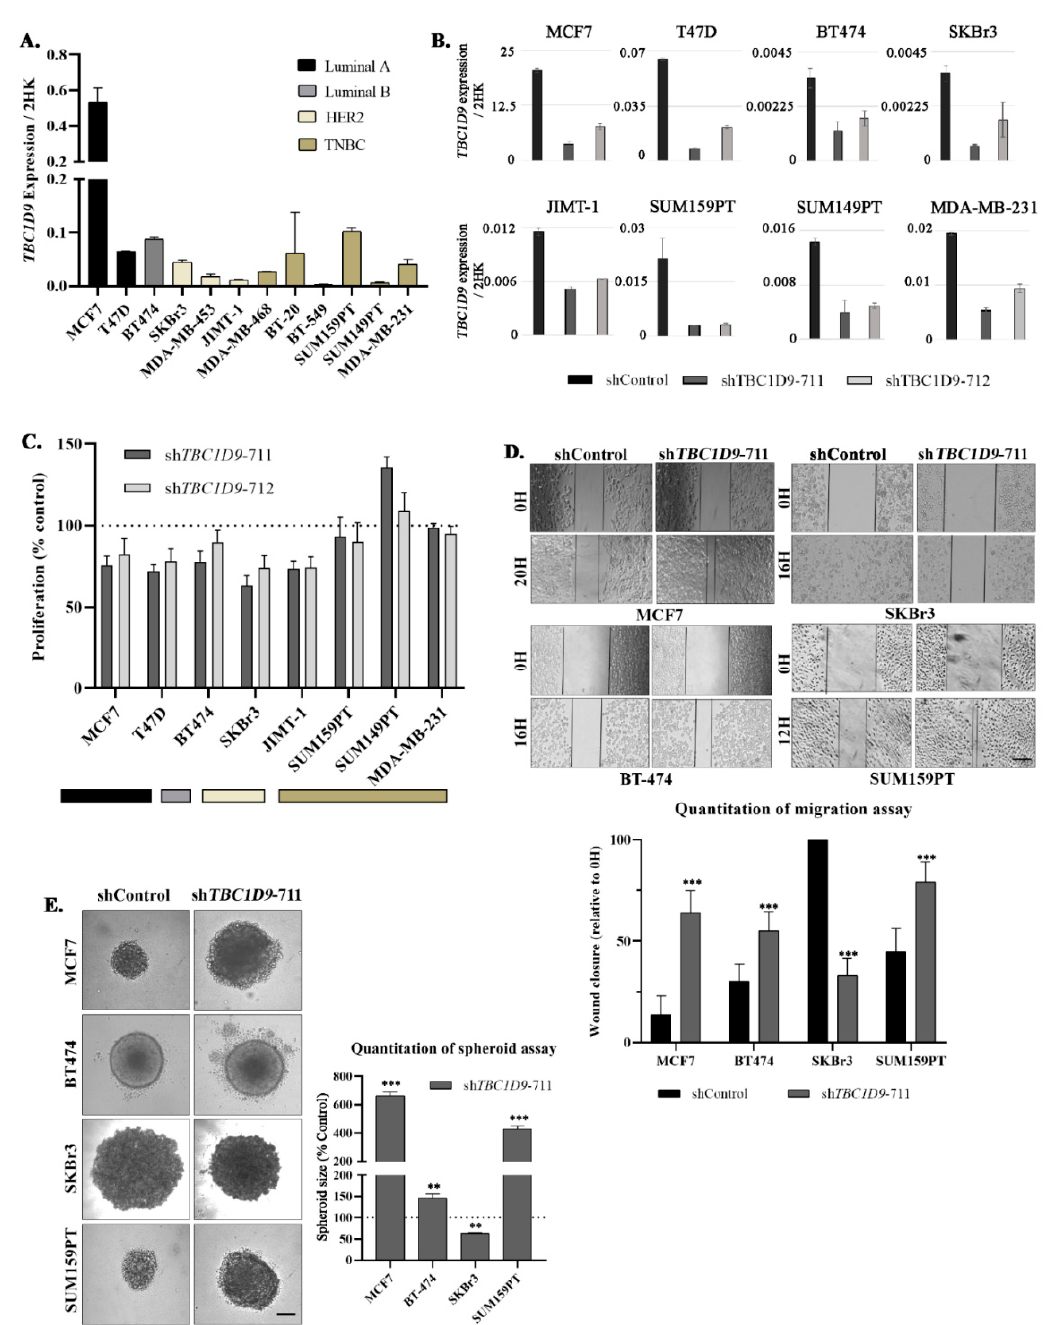
Figure 3. Effect of TBC1D9 knockdown on different phenotypes of BC. Screening of TBC1D9 expression in different BC cell lines ( A ). Validation of TBC1D9 knockdown by sh TBC1D9 -711 and sh TBC1D9 -712 in BC cell lines: luminal A (MCF7, T47D), luminal B (BT474), HER2 (SKBr3, JiMT-1), and TNBC (SUM159PT, SUM149PT, and MDA-MB-468), with the two housekeeping genes (2HK) GAPDH and HPRT1 ( B ). Effect of TBC1D9 knockdown on proliferation ( C ), migration ( D ), and the 3D spheroid formation assay ( E ). Scale bar: 100 µ m. H = hour; ** p = 0.005; *** p =